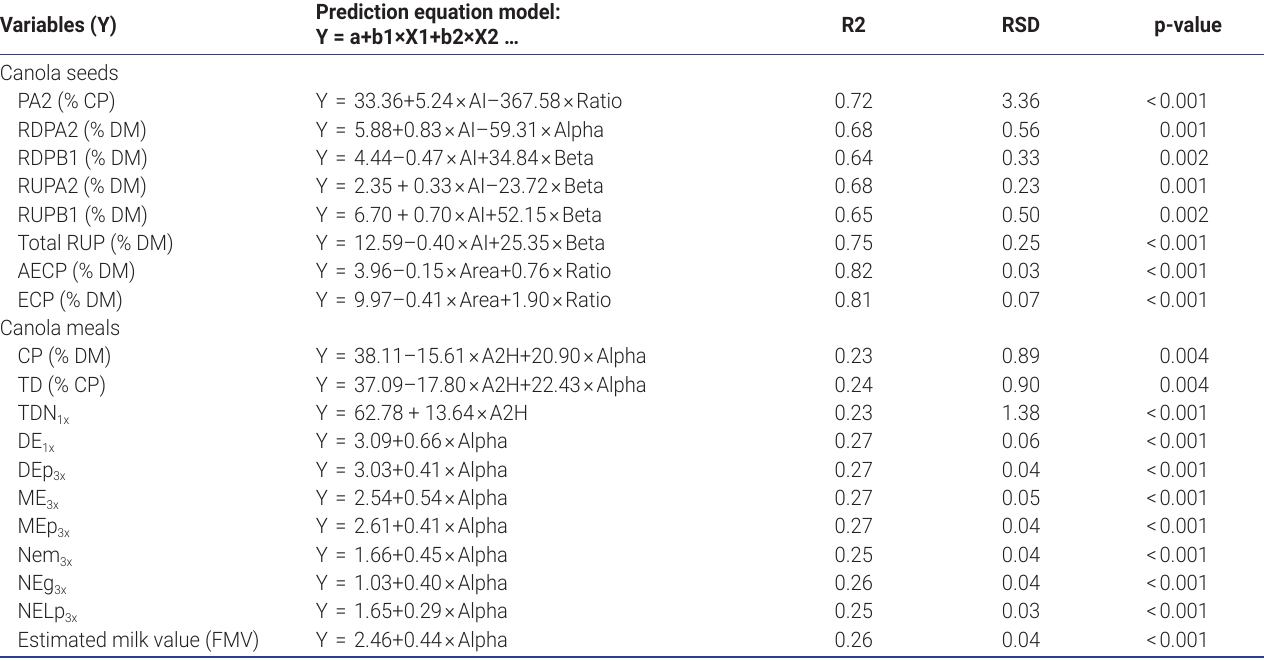
Table 20. Best model variables selection in multi-regression analysis to predict Canola protein parameters from FTIR protein structures Variables (Y)